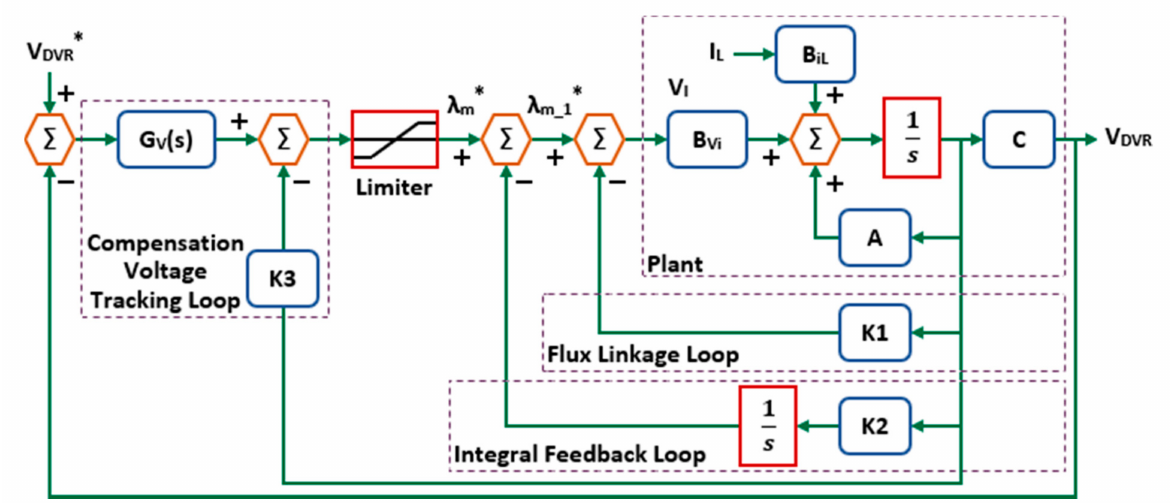
Figure 31. Block diagram for direct flux linkage control technique in